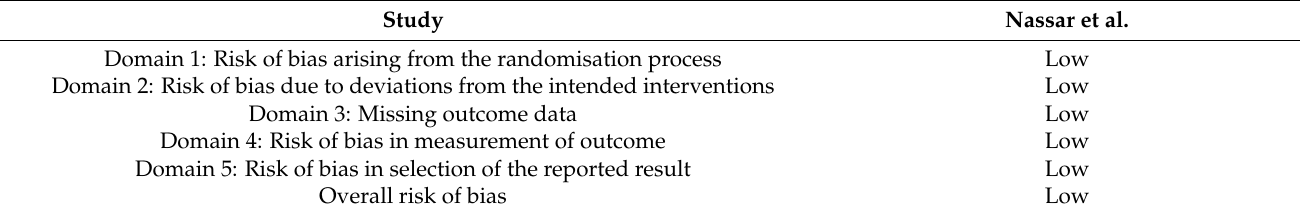
Table 4. Cochrane Risk of Bias Tool